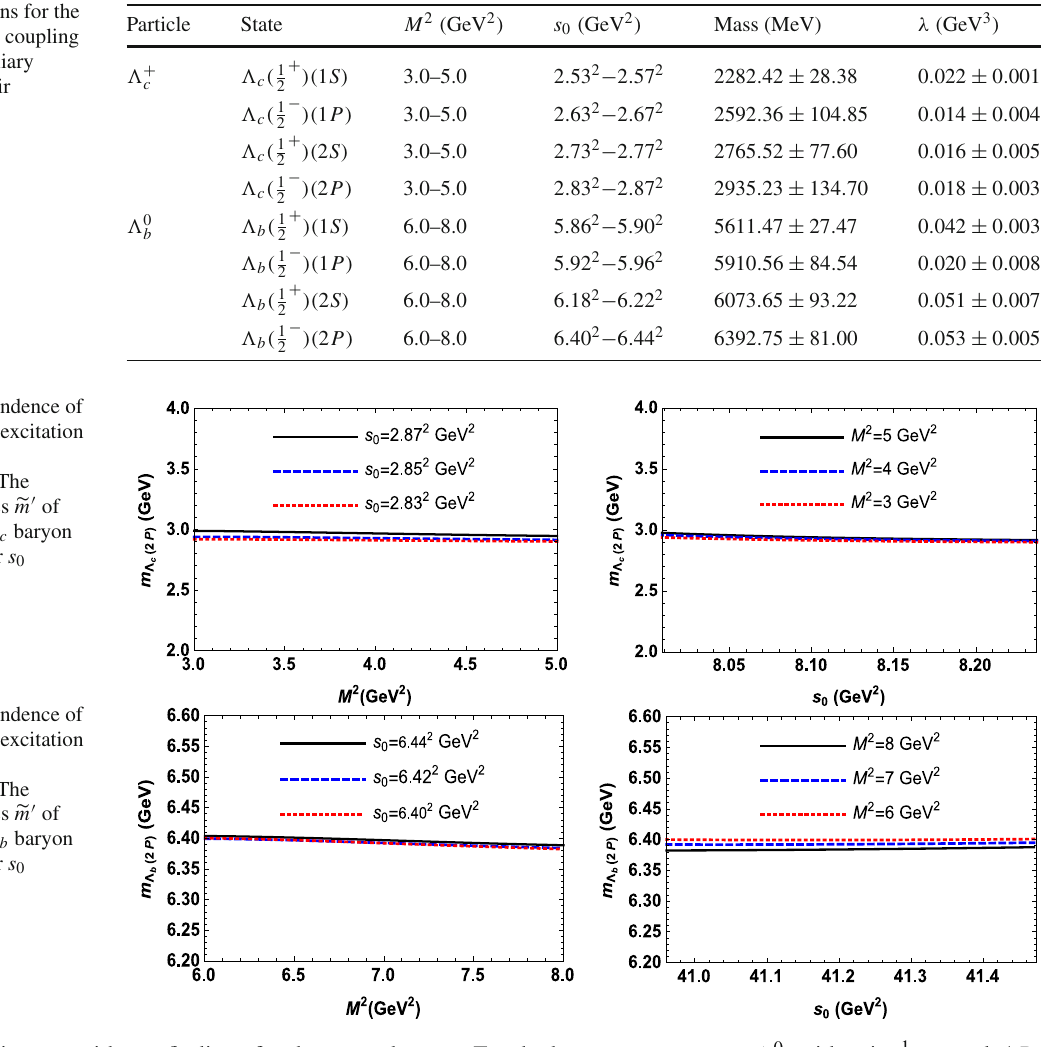
Fig. 2 Left: The dependence of the mass (cid:11) m (cid:5) of the 2 P excitation of (cid:2) c baryon on Borel parameter M 2 . Right: The dependence of the mass (cid:11) m (cid:5) of the 2 P excitation of (cid:2) c baryon on threshold parameter s 0